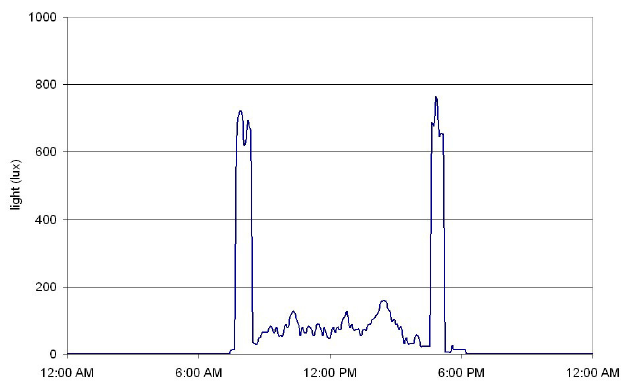
Fig. 10. Light measured in an office during one working